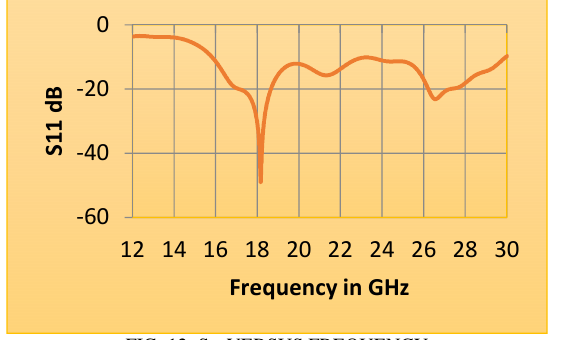
FIG. 15. PECTORIAL VIEWS OF THE PATCH AND GROUND